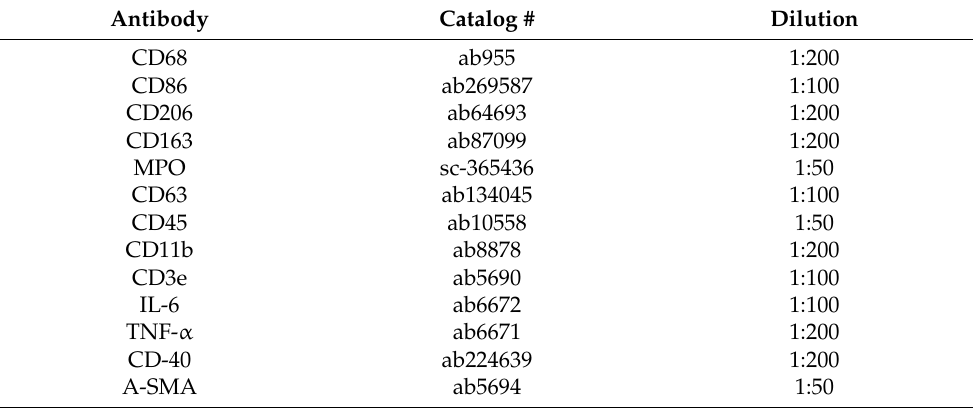
Table 1. Primary antibodies and the dilution factor used for immunostaining and immunofluores- cence in this